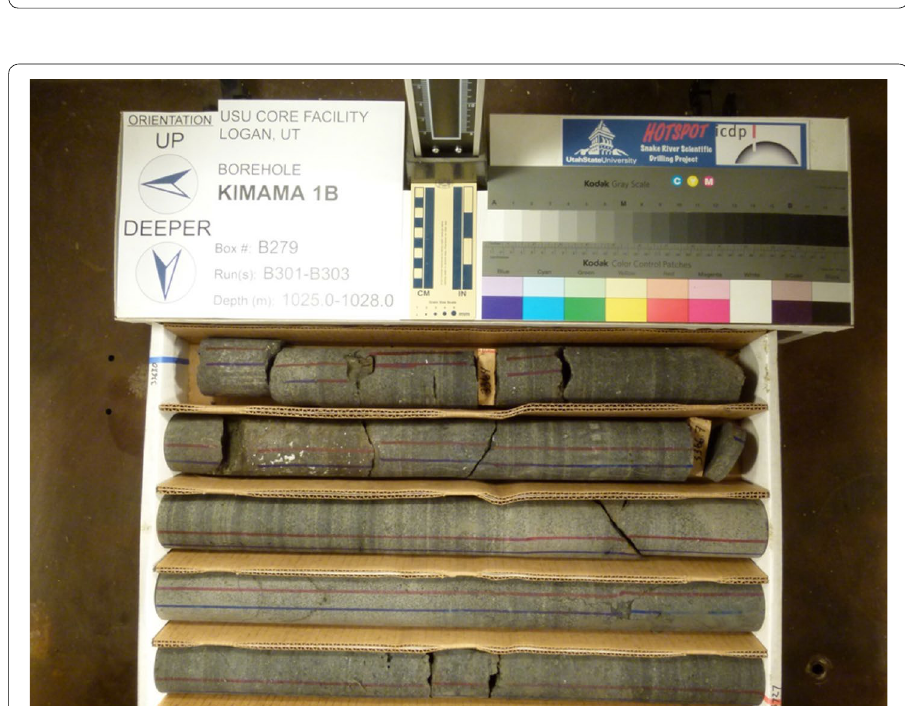
Fig. 7 Core from 1025 to 1028 m. Basalts have a greenish tint as well as clay deposition and other secondary minerals filling vesicles and